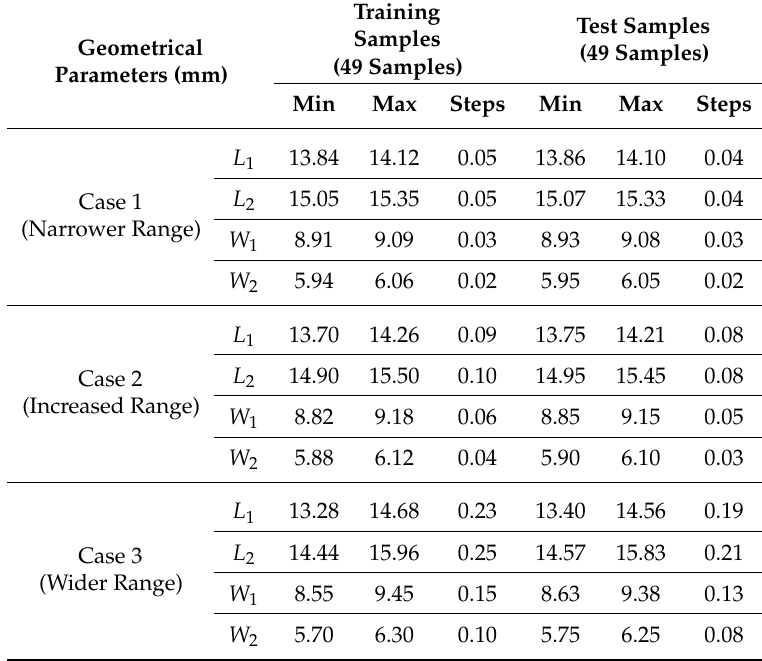
Table 2. Definition of training and test samples for the three-order waveguide filter